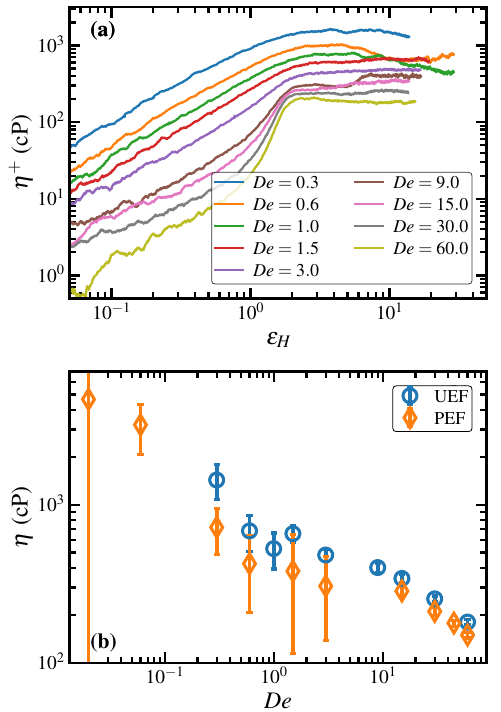
Figure 6. Startup (( a ); UEF only) and steady-state (( b ); both UEF and PEF) viscosity for the PE melt undergoing elongational flow at various De . Statistical error bars are indicated for the steady-state data displayed in panel ( b ).